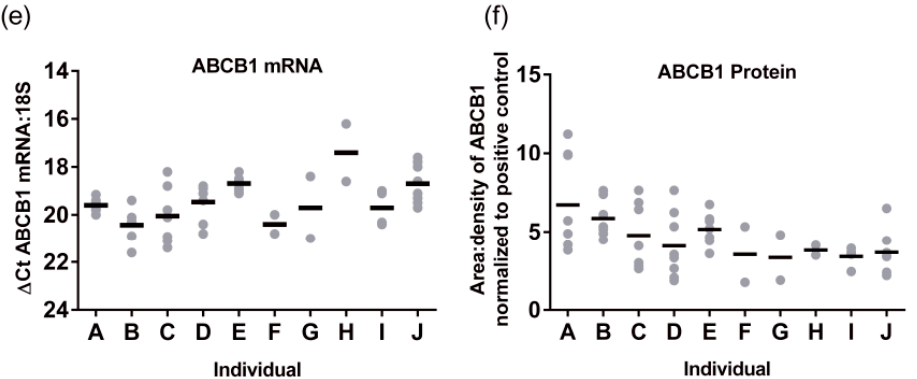
Figure 1. Expression of ABCB1 within different human liver regions. ( a ) Diagram of the different regions where samples taken within the same liver; ( b ) The mRNA expression of ABCB1 was determined within different regions of 14 different livers; ( c ) Protein expression of ABCB1 within different human liver regions: (distal large lobe n = 8; distal small lobe n = 6), medial large lobe n = 7; medial small lobe n = 6, central large lobe n = 10, central small lobe n = 5, APC = adjacent to portal circulation n = 6 and ABD = adjacent to bile duct N = 11); ( d ) Correlation between mRNA expression and protein expression for ABCB1, with 95 % confidence intervals (dotted line), and data analyzed by Spearman’s correlation; ( e ) ABCB1 mRNA expression (line = means) within the livers of 10 individuals; ( f ) The ABCB1 protein expression showing intra-individual variability of protein expression (8 regions for A, D, E, J; 7 regions for B and C; 4 regions for I and 2 regions for F, G and H).